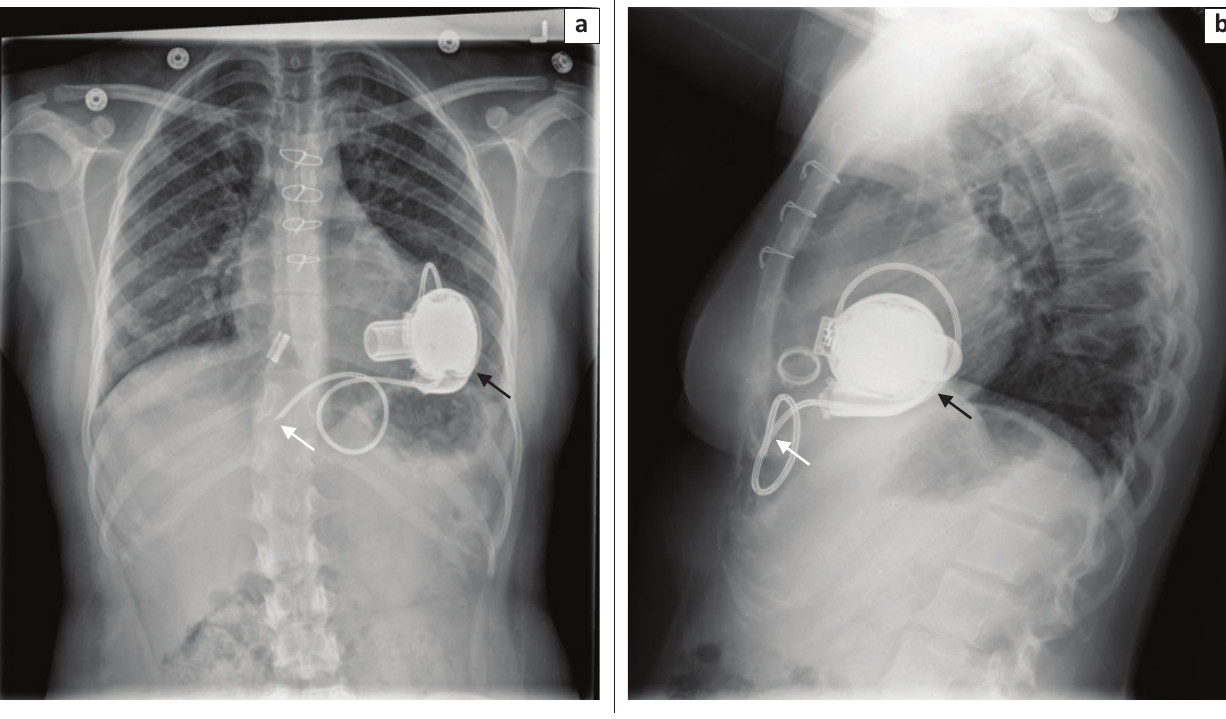
FIGURE 11: Frontal (a) and lateral (b) chest radiographs showing a decommissioned HeartWare left ventricular assist device (thick arrow) with an intentionally severed driveline (arrow) in a 33-year-old lady with a history of left coronary